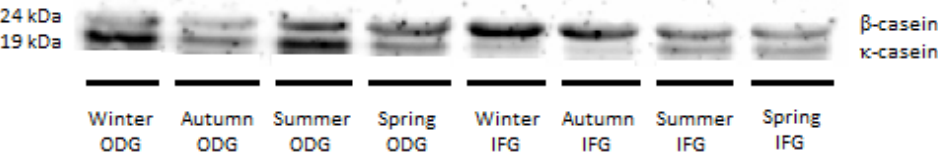
Figure 2. A representative Western Blotting of caseins β and κ resulting from milk samples obtained in four different seasons between two different farming systems. ODG: Outdoor grazing, IFG: intensive feeding.